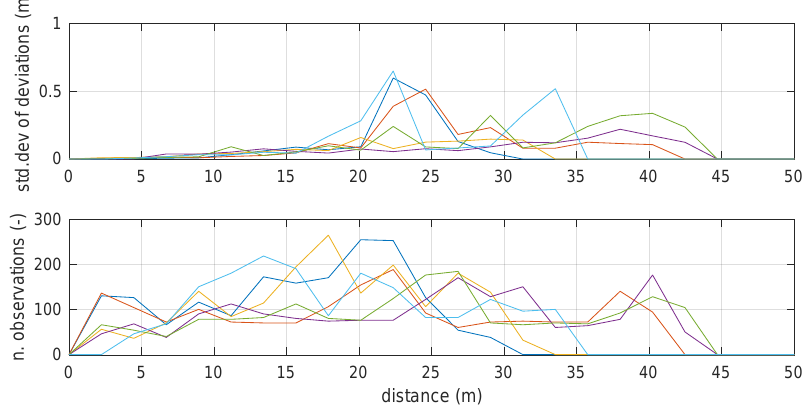
Figure 9. Standard deviation of measurement distance deviations at different distance ranges for the six anchors. The binning is defined by dividing the measurement range into 40